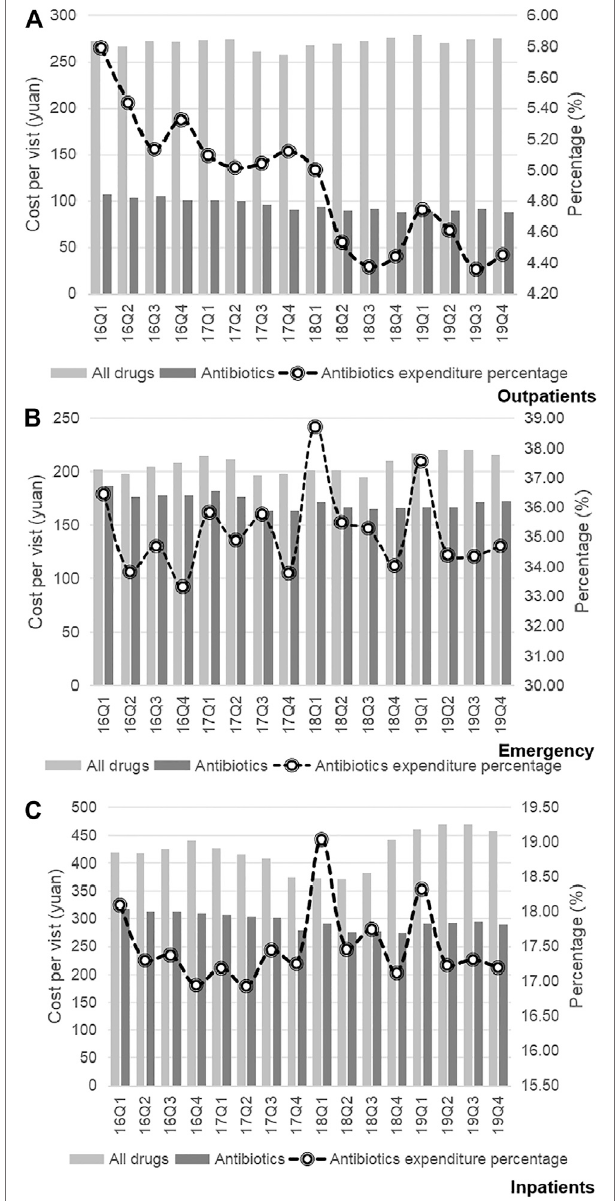
FIGURE 4 | (A) Changes in antibiotics expenditure in Outpatients, 2016 – 19. (B) Changes in antibiotics expenditure in Emergency, 2016 – 19. (C) Changes in antibiotics expenditure in Inpatients, 2016 –